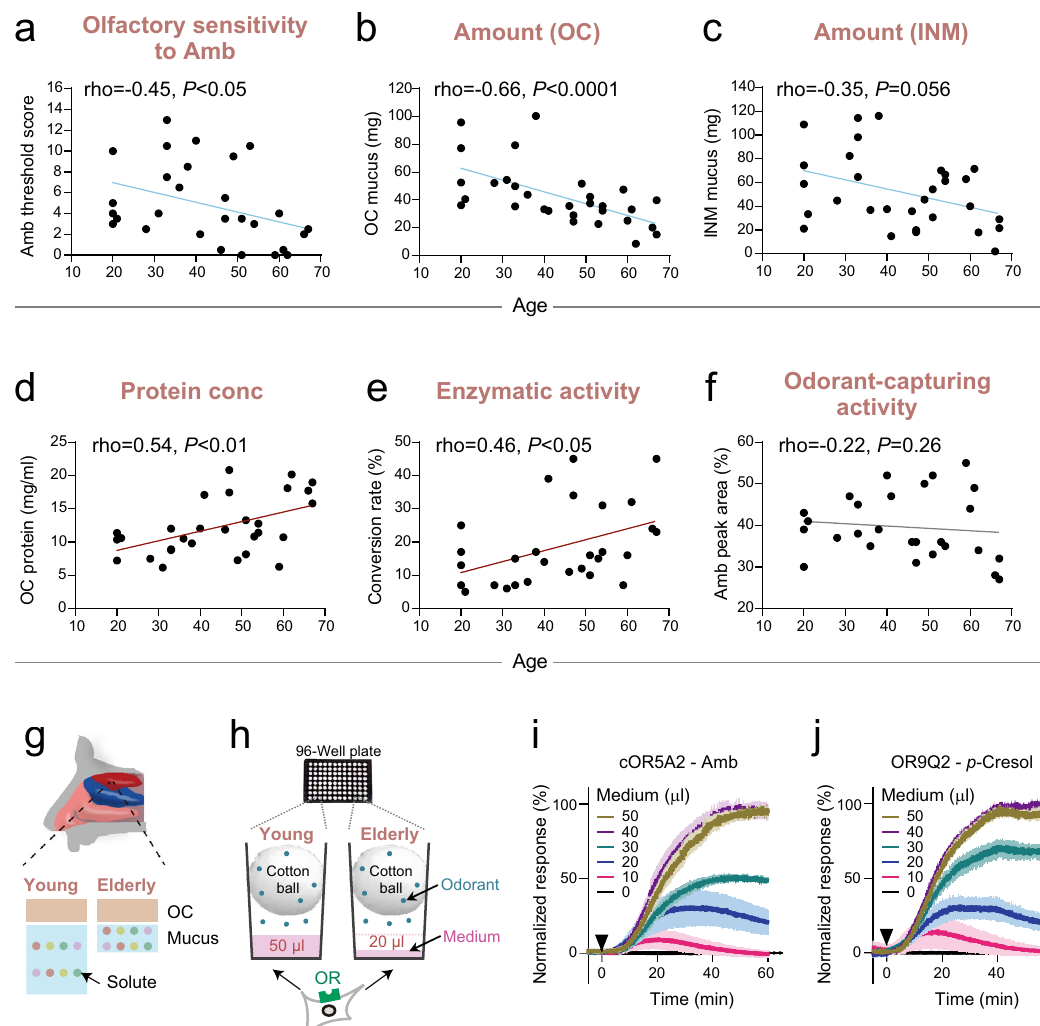
Figure 5. Relationship between the decline in olfaction and change in olfactory cleft mucus with aging. ( a–f ) Factors associated with age. The x-axis indicates the age of participants, and the y-axis represents olfactory threshold values for ambrettolide (Amb; a , n = 28), amount of olfactory cleft (OC) mucus ( b , n = 30), amount of inferior nasal meatus (INM) mucus ( c , n = 30), protein concentration in the OC mucus ( d , n = 30), conversion rate from p -cresyl acetate ( p CA) to p -cresol in × 10 diluted OC mucus ( e , n = 29), and relative headspace concentration of Amb emitted from the OC mucus ( f , n = 28). ( g ) Graphical summary of age-dependent changes in olfactory mucus. The OC mucus decreased in amount and increased in the concentration of components with aging. ( h ) Experimental procedure for assaying the activation of olfactory receptor (OR)-expressing cells covered with different amounts of medium (0–50 μL), which mimic the age-dependent decrease in the amount of OC mucus. Cotton balls saturated with odorants (100 μM) were placed above cells in each plate well. ( i , j) Response of cOR5A2 or OR9Q2-expressing cells against Amb or p -cresol diffusing from the vapor phase. The response was normalized with the maximum response in the 50 μL condition. Each line shows the average response from three independent experiments. The vertical shades represent standard